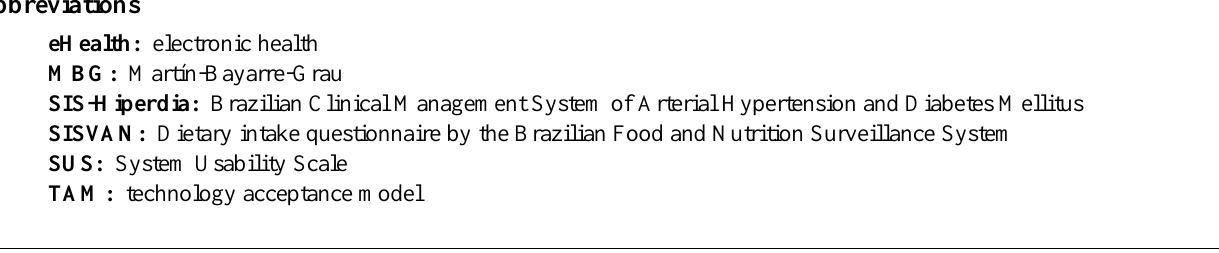
MBG: Martín-Bayarre-Grau SIS-Hiperdia: Brazilian Clinical Management System of Arterial Hypertension and Diabetes Mellitus SISVAN: Dietary intake questionnaire by the Brazilian Food and Nutrition Surveillance System SUS: System Usability Scale TAM: technology acceptance